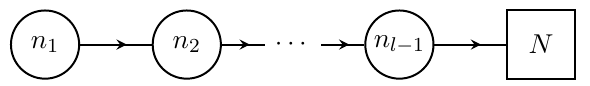
Figure 2 . A quiver diagram for the gauged linear sigma model that is described by the sigma model on a (cid:13)ag